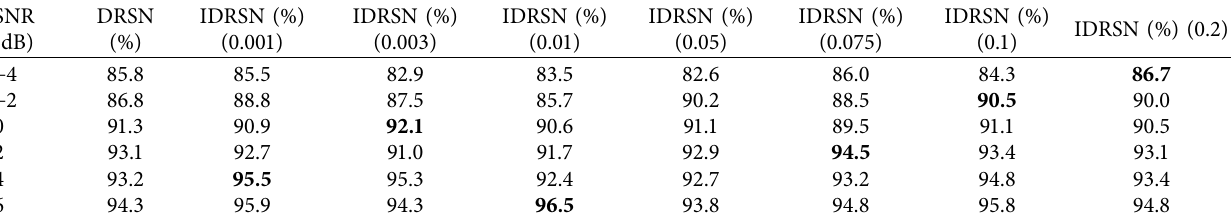
Table 3: Fault diagnosis results of the DRSN and